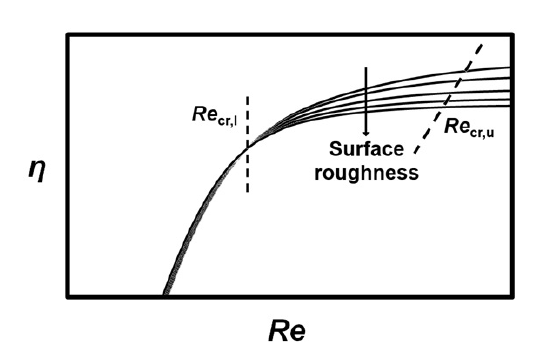
Figure 1. Schematic view of a change in compressor efficiency with a varying Reynolds